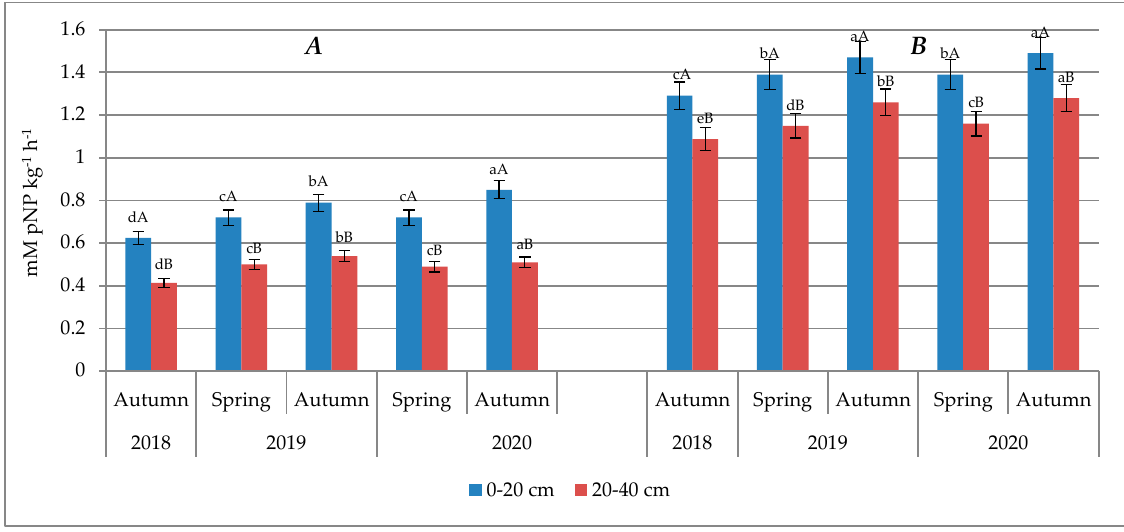
Figure 4. ( A , B ). Activity of alkaline (AlP) ( A ) and acid (AcP) ( B ) phosphatases in the studied soil. Different lower-case letters indicate significant differences among the soil sampling seasons (2018 autumn, 2019 and 2020 spring, autumn). Different upper-case letters indicate significant differences among the levels of sampling. Error bars represent standard deviation.